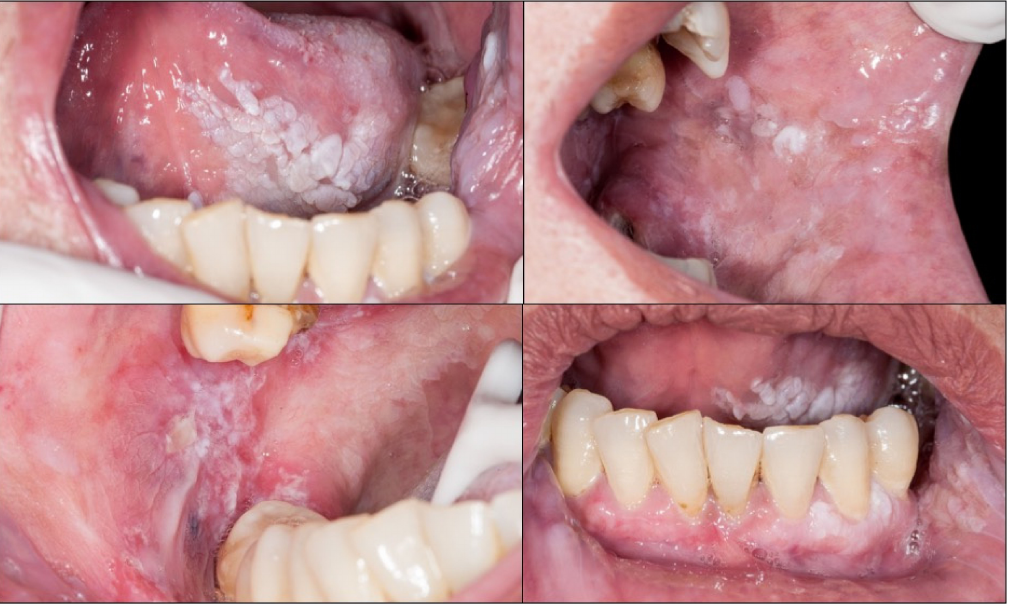
Figure 3. Proliferative verrucous leukoplakia. The presence of white multifocal lesions affecting the tongue, buccal mucosa, and gingivae should be noted.